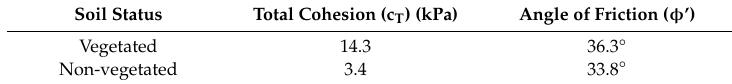
Table 5. Average values of strength parameters used for slope stability analysis.